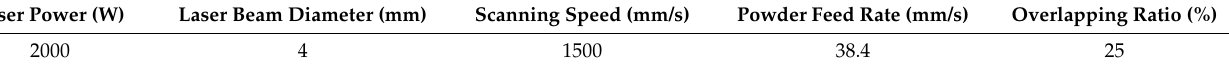
Table 2. Laser cladding parameters.